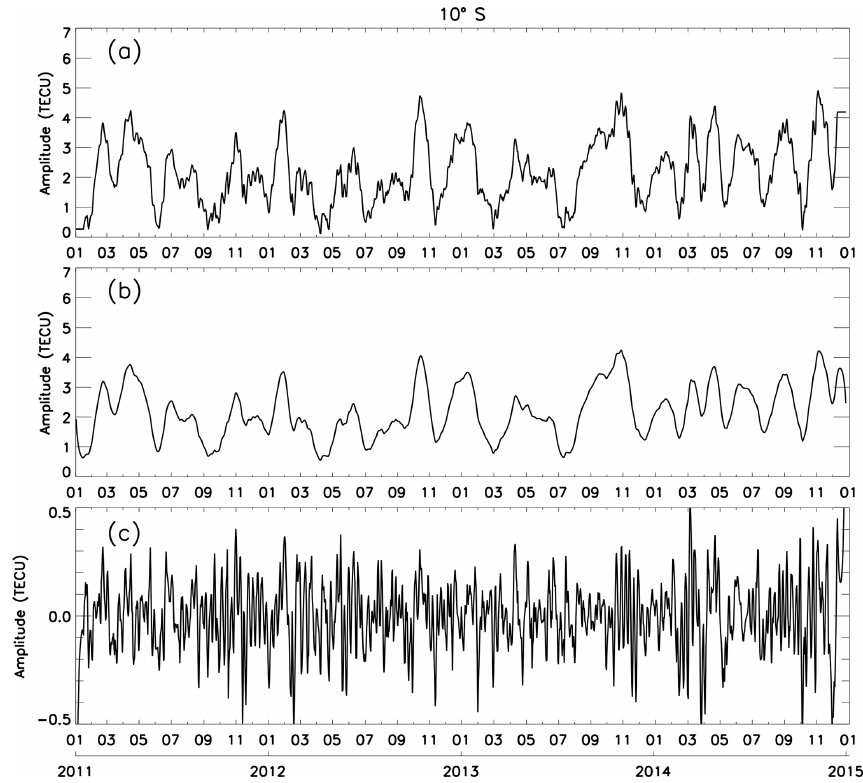
Figure 1. (a) Amplitudes of the lunar semidiurnal tide from 2011 to 2014 calculated at 10 ◦ S (magnetic latitude). (b) Low frequencies ( < 1 / 30d − 1 ) calculated using a Butterworth kernel filter from amplitudes of (a) . (c) Same as (b) but for high frequencies ( > 1 / 30d − 1